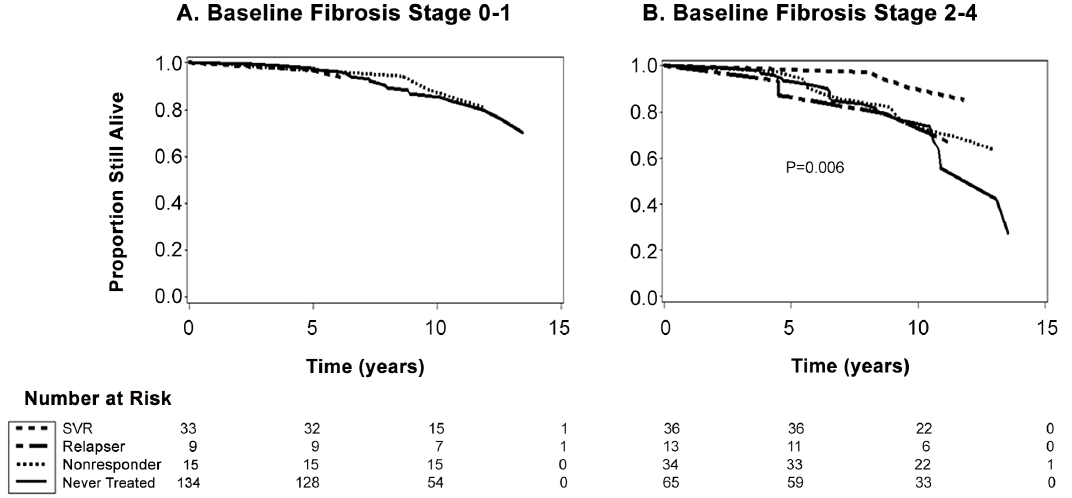
Figure 2. Proportion remaining alive among SFVA patients with baseline liver fibrosis stage 0–1 (panel A) and stage 2–4 (panel B). Age adjusted proportional hazards curves indicate that there were no significant differences in survival among the four treatment groups in patients with fibrosis stage 0–1 (panel A). Among patients with fibrosis stage 2–4, SVR significantly improved survival compared to never treated patients (p=0.006), unadjusted for other risk factors (panel B).